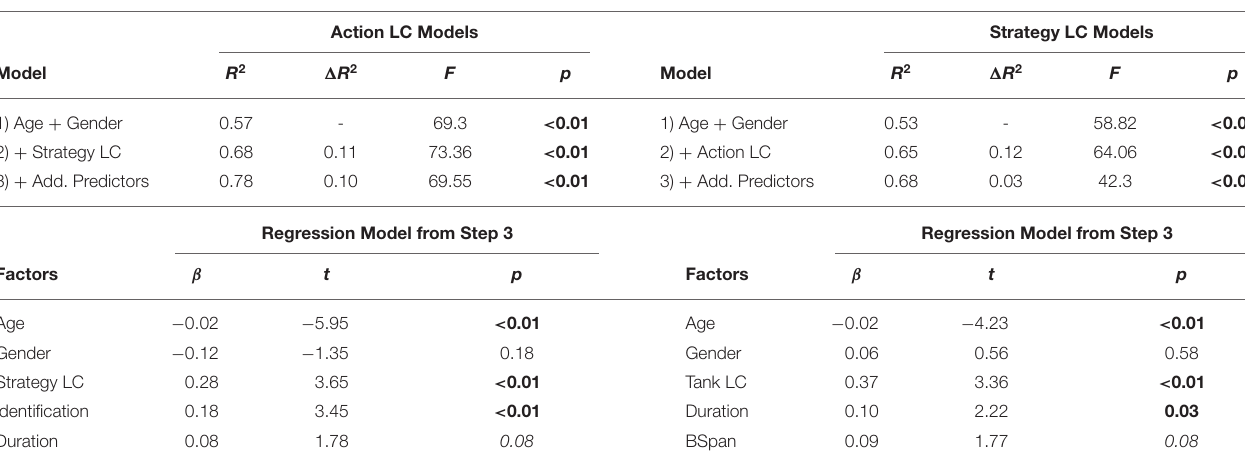
TABLE 4 | Results from follow-up regression models, after controlling for opposite game learning.